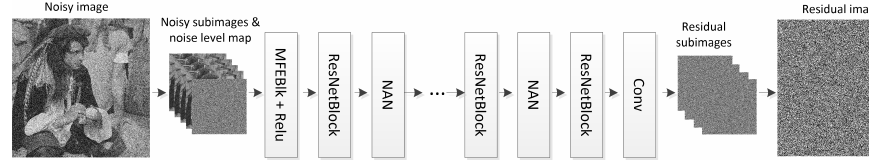
Figure 1. The architecture of MFENANN.